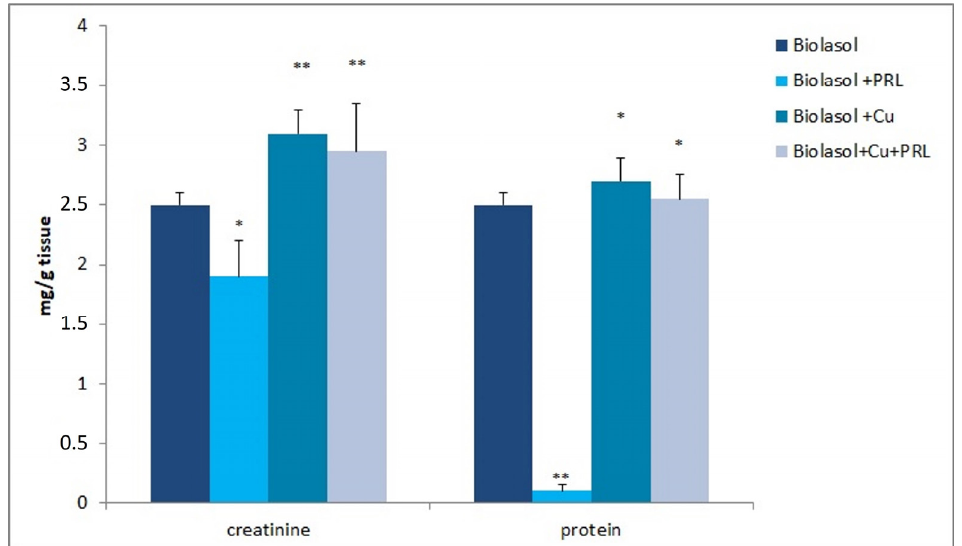
Figure 6. Potassium concentration in the perfusate samples collected. The values are expressed as mean ± SEM. Data were analysed by one-way ANOVA and Bonferroni post hoc tests; n = 10; * p < 0.05 compared to the control group (Biolasol).